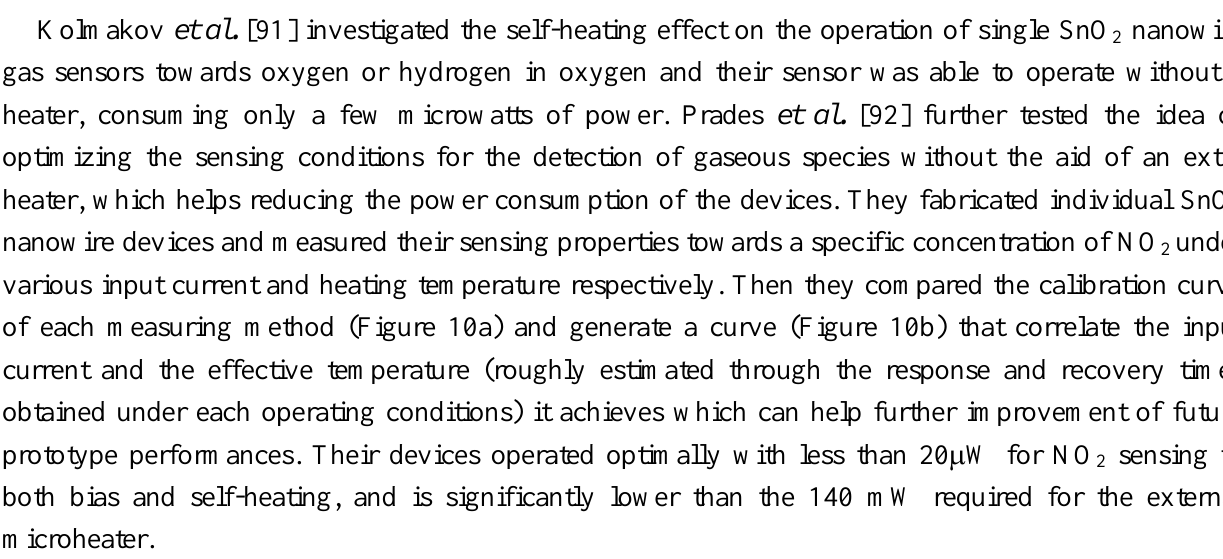
Figure 10. (a) comparison of the responses obtained with both measuring